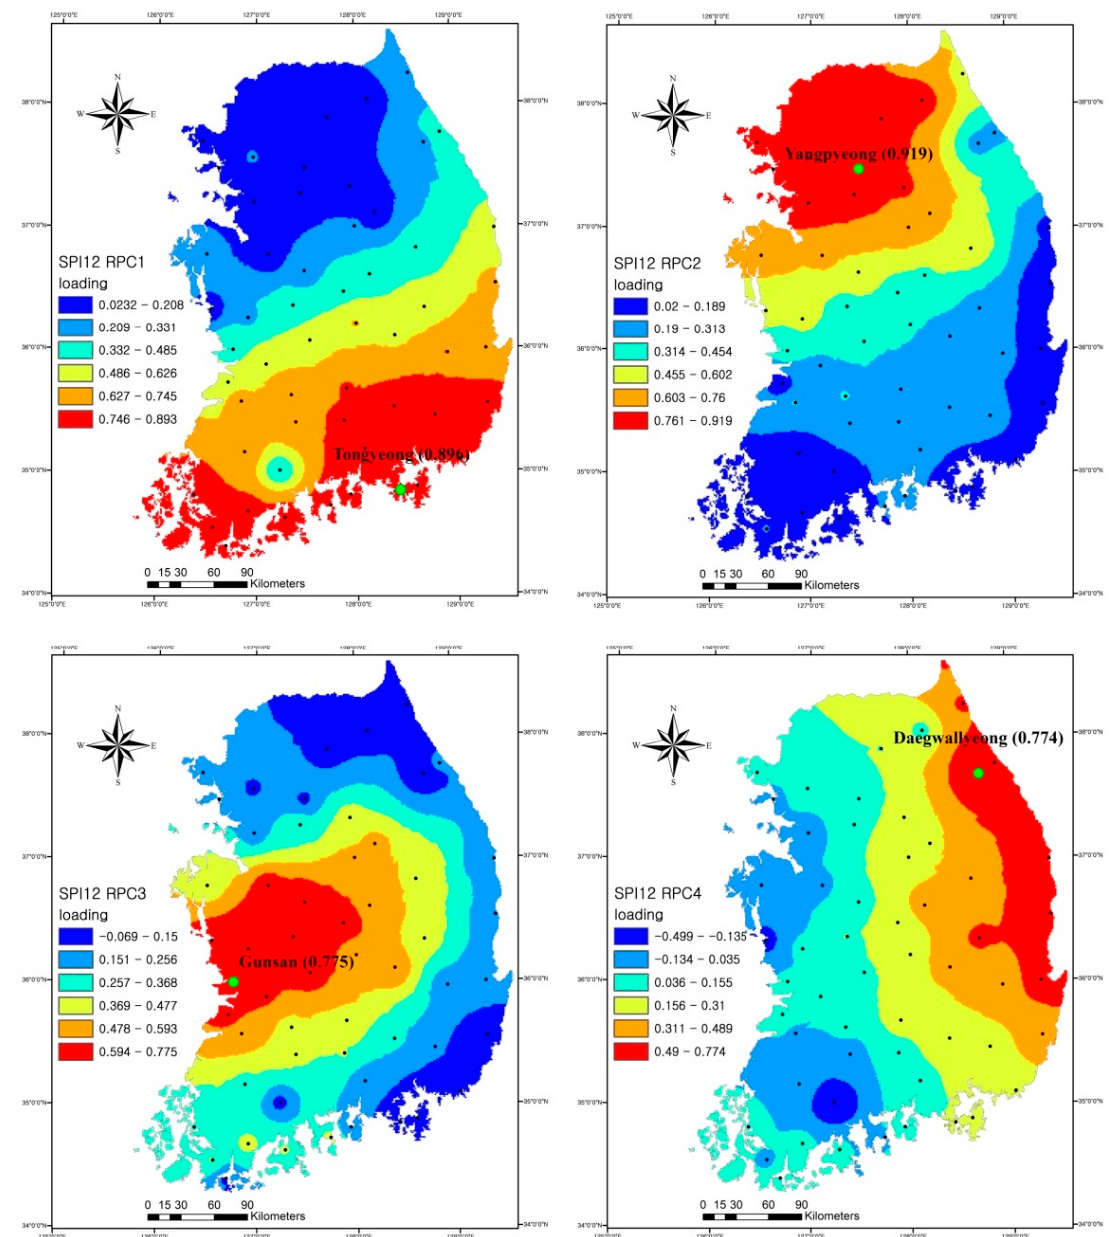
Figure 7. Spatial variability of rotated loading of the leading four principal components based on principal component analysis applied on drought time